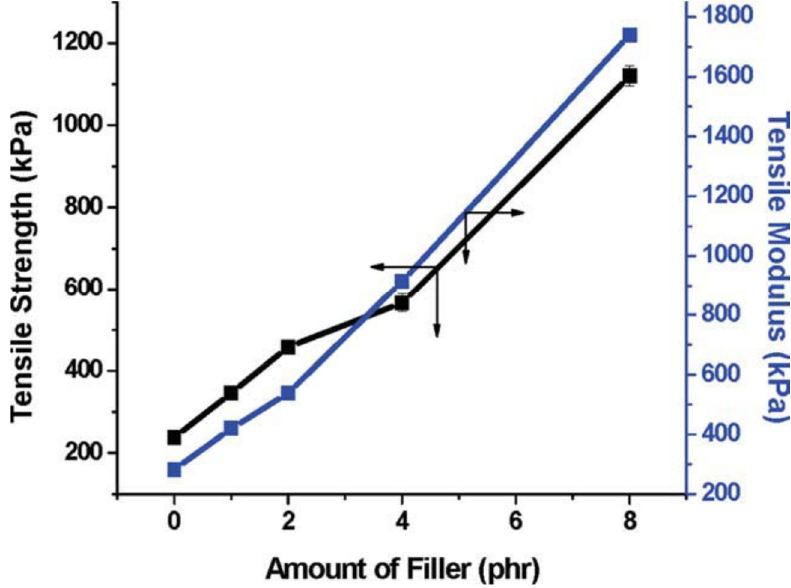
Figure 18. Plot of tensile strength and tensile modulus for in situ prepared amine modified